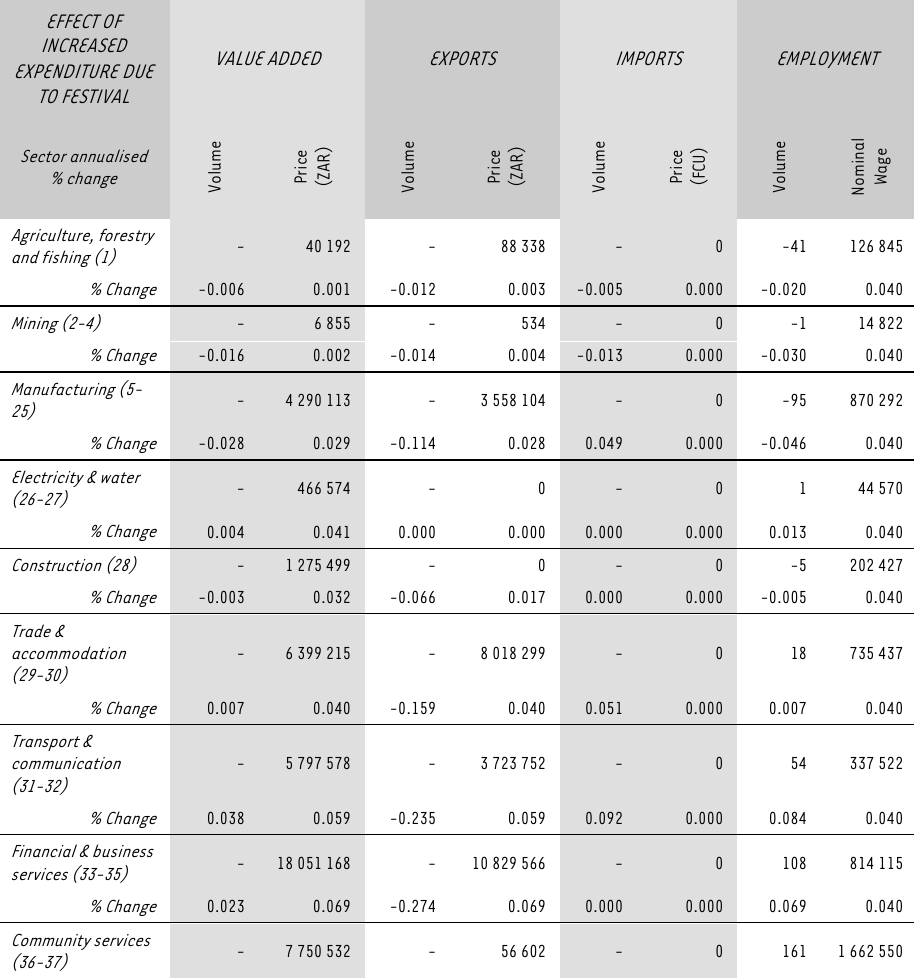
TABLE 12: Aggregate sectoral level impacts (structural effects for the regional model only)